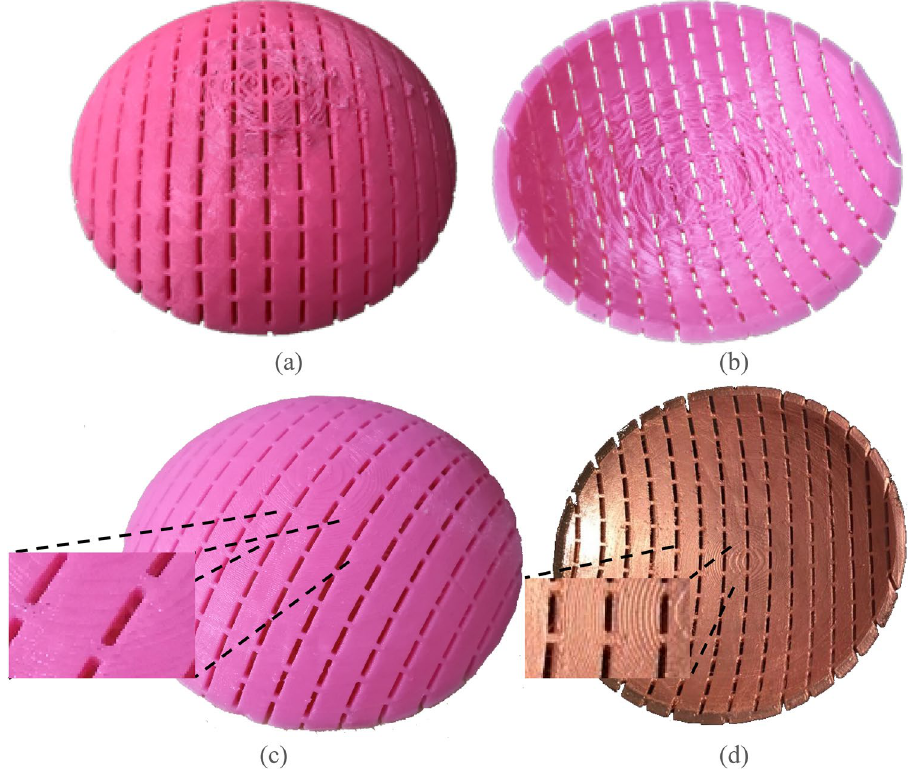
Figure. 6. (a) Photo of the convex side of the 3D printed conformal FSS without using support structures when it was printed with the convex side face down; (b) photo of the concave side of the 3D printed conformal FSS without using support structures when it was printed with the convex side face up; (c) photo of the convex side of the 3D printed FSS with strategically selected support structures and optimized print settings when it was printed with the convex side face up; (d) photo of the 3D printed conformal FSS with the optimized print settings after